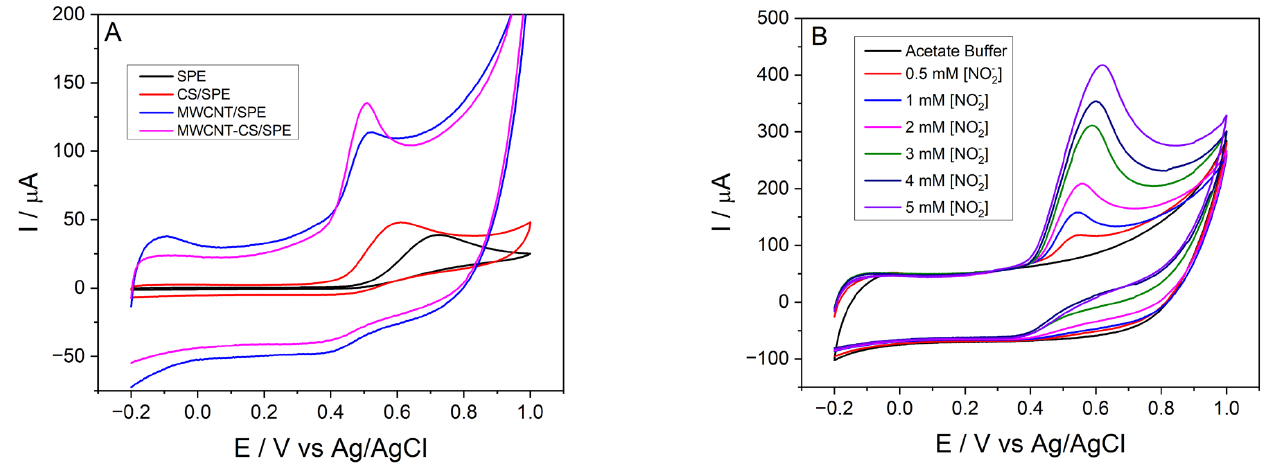
Figure 4. Cyclic voltammograms recorded for oxidation of: ( A ) 1 mM of nitrite on bare SPE- (a), CS/SPE- (b), MWCNT/SPE- (c), and MWCNT-CS/SPE-based sensors (d), and ( B ) 0.5, 1, 2, 3, 4, and 5 mM of nitrite on MWCNT-CS/SPE ( acetate buffer 0. 1 M, pH 5, ν = 0 .05 V/s).